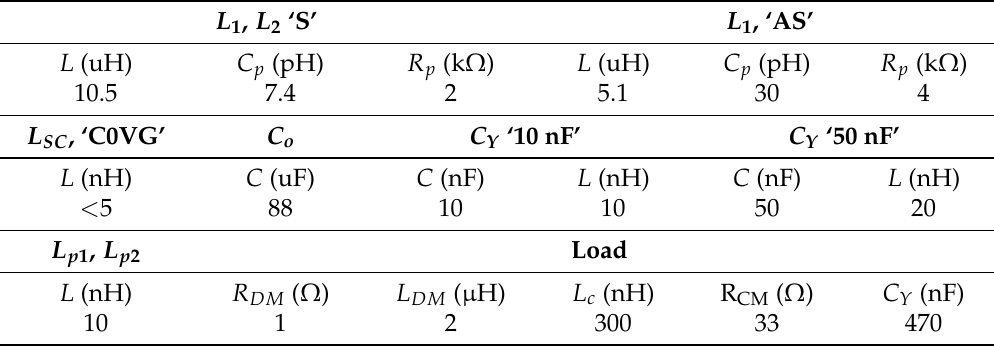
Table 3. Parameters of the output filter and load